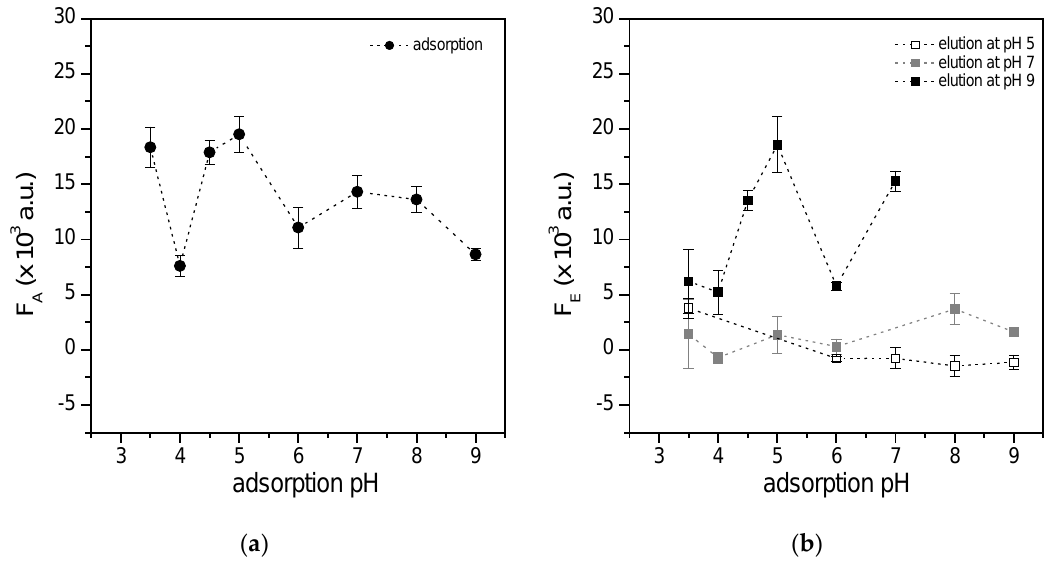
Figure 2. MicroRNA adsorption (Panel ( a )) and elution (Panel ( b )) from flat polydimethylsiloxane (PDMS) surfaces as a function of pH. Panel ( a ): 10 ng of synthetic miR-1246, conjugated with the florescent dye TAMRA, were incubated on the silanized surfaces at different pH. After three washes with the same buffer as for incubation, the fluorescence of the adsorbed microRNA was measured (F A ). Panel ( b ): fluorescence of the eluted microRNA (F E ). The microRNA adsorbed at different pH was eluted from the surfaces with buffers at three different pH values: pH = 5 (white squares), pH = 7 (gray squares) and pH = 9 (black squares). After elution, surfaces were imaged and the resulting signal was subtracted from F A , obtaining values of the eluted microRNA (F E ). Data are means of at least three independent replicates, while error bars represent standard errors.